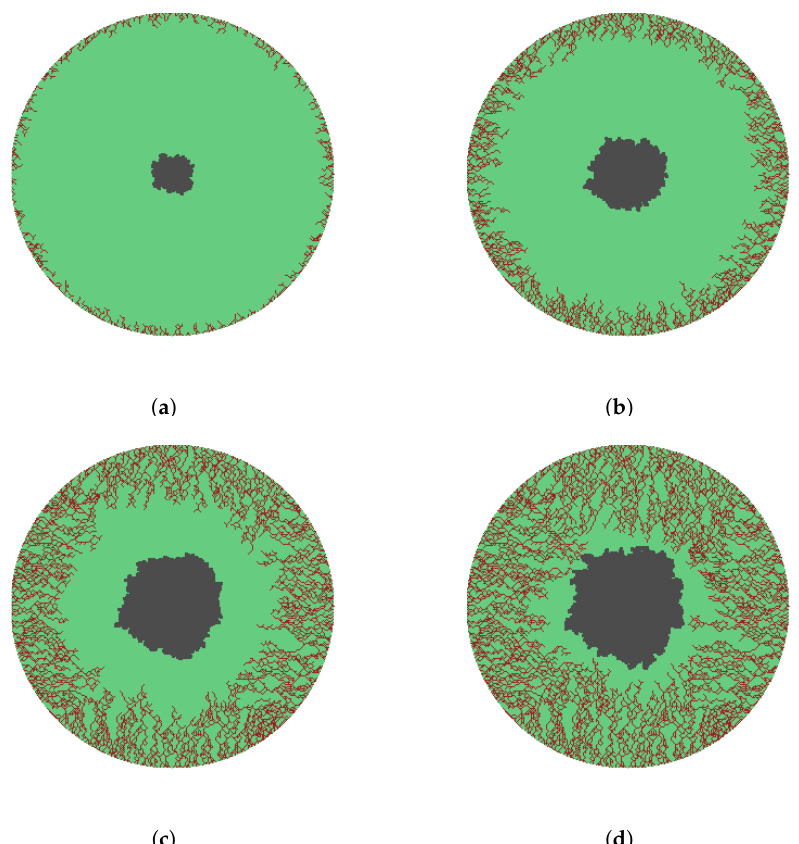
Figure 10. Eden model simulation of angiogenesis and bacteria infection for a circular skin wound. is wound space, is vasculature growth, and is bacteria growth. Compared to the initial wound, vascularization and bacteria burden at the different stages are approximately ( a ) 11% and 2% ; ( b ) 31% and 6%; ( c ) 59% and 10%; and ( d ) 77% and 13%. The capillary growth rate is 1 step, the branching length is 2 steps and the bacteria growth rate is half a